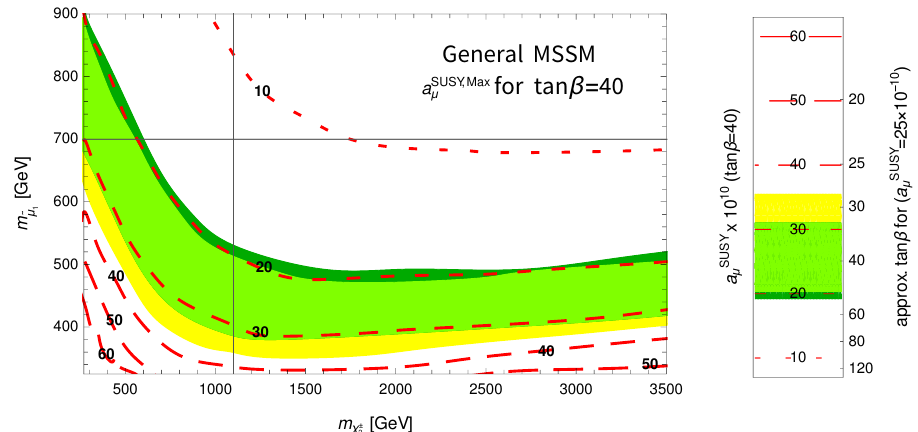
for tan β = 40 in the plane Figure 15. The theoretical maximum MSSM contribution a SUSY,Max µ of the heaviest chargino and the lightest smuon mass. (For each point in the plane, the actual value of the MSSM contribution can take any value between 0 and ± a SUSY,Max , depending on the µ signs of parameters and details such as other masses and mixings.) The yellow/green coloured regions show where a SUSY,Max (for tan β = 40 ) is within the 1 σ bands corresponding to the BNL µ and new deviations ∆ a BNL and ∆ a 2021 , see eqs. (1.6), (1.7), and their overlap. The red dashed µ µ contour lines can be interpreted in two ways. Firstly, they directly correspond to certain values of for tan β = 40 , as indicated in the left axis of the legend plot. Secondly, thanks to the a SUSY,Max µ approximate linearity in tan β , each contour can be used to estimate the required tan β value for which a SUSY,Max agrees with the deviation ∆ a 2021 (keeping other input parameters fixed). These µ µ tan β values can be read off from the right axis of the legend plot (the values are approximate since the linearity is not exact). As an example of the reinterpretation we take the point m = 1750 GeV χ ± 2 and m = 700 GeV. For tan β = 40 we get a SUSY,Max = 10 × 10 − 10 . The required tan β value to get ˜ µ 1 µ ∆ a 2021 would be around 100, as read off from the right axis. The results for a SUSY,Max were obtained µ µ from a scan using GM2Calc [45] in which all relevant SUSY masses are varied independently between 100 GeV and 4 TeV. The black lines indicate the maximum LHC reach for charginos and sleptons of 1100 and 700 GeV reported in refs. [487, 490],